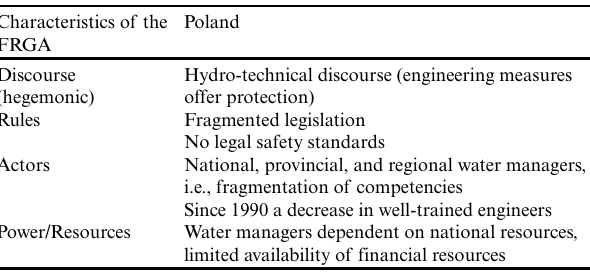
Table 7 . Characteristics of the Polish flood risk governance arrangement (FRGA) before the flood event of